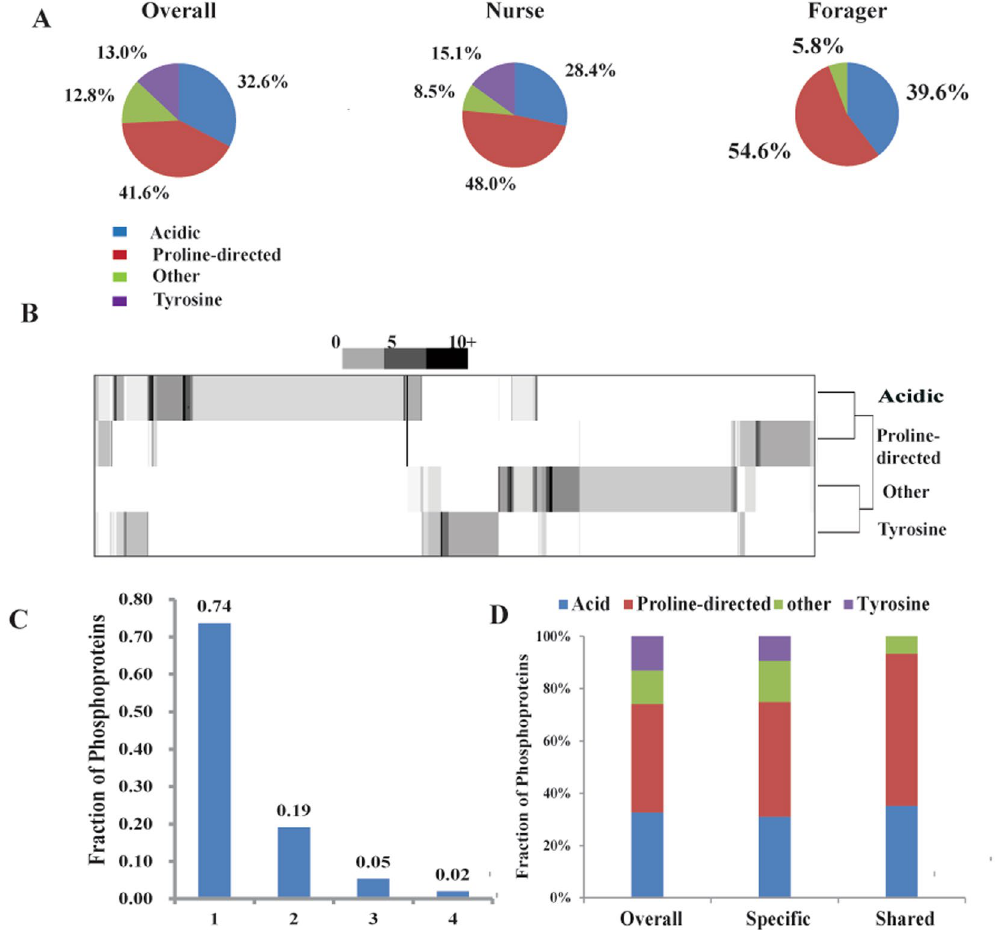
Figure 3. Overview of phosphosite classes across the different ages. ( A ) The relative frequencies with which each class is observed overall and for each worker age is plotted as pie charts. ( B ) The heat map presents the numbers of sites of each class observed for 566 phosphoproteins. Proteins and site classes have been clustered to highlight similarities. ( C ) Histogram indicating relative proportions of phosphoproteins containing phosphosites from variable numbers of classes. ( D ) Bar graph indicating relative proportions of age-specific and shared phosphosites in